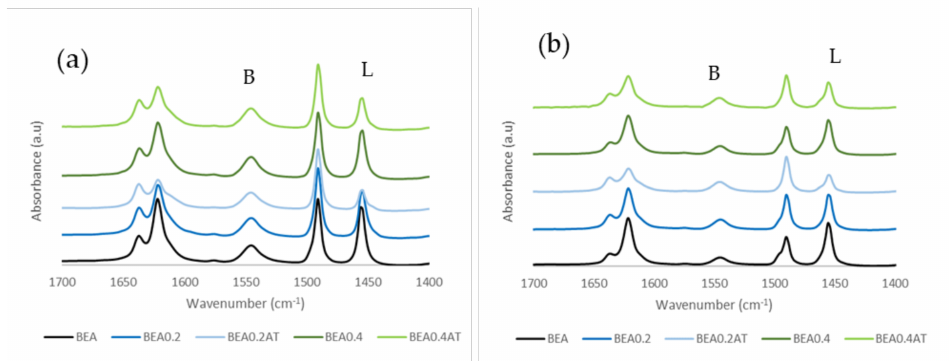
Figure 2. Infrared spectra of parent and treated BEA after pyridine adsorption on (B) Brönsted and (L) Lewis acid sites upon degassing at ( a )150 ◦ C and ( b ) 350 ◦